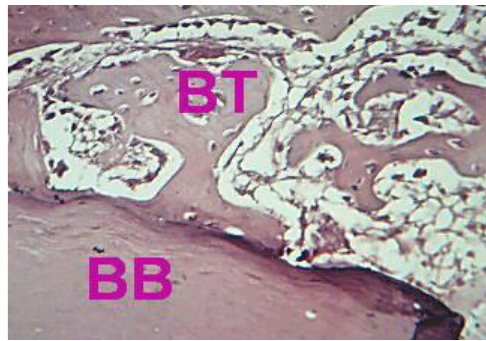
Figure 11: Bone trabeculae (BT) coalesce with basal bone (BB).